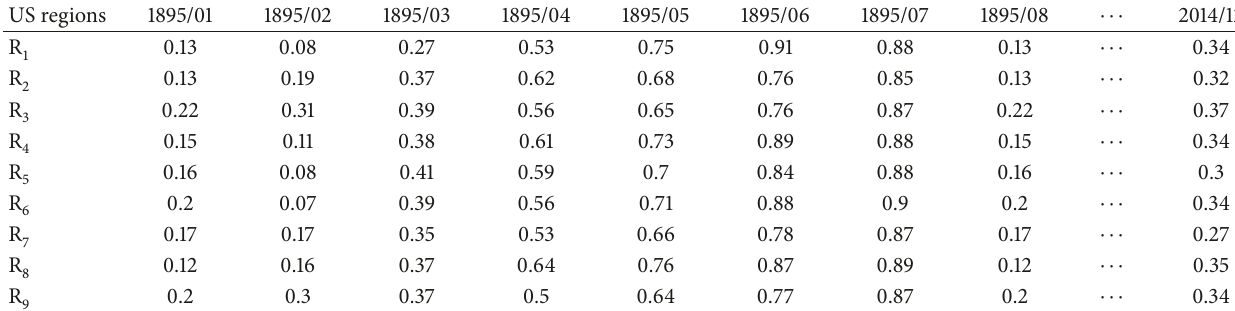
Table 2: Normalized temperature values.